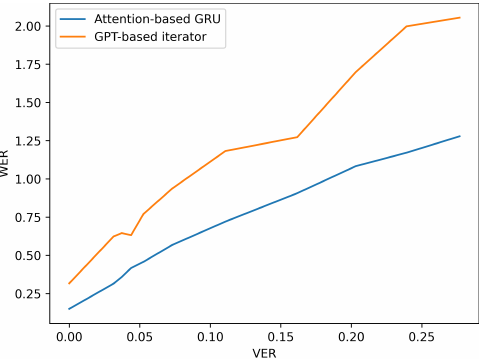
Figure 13. WER performance under varying noise levels (evaluation on LRS3